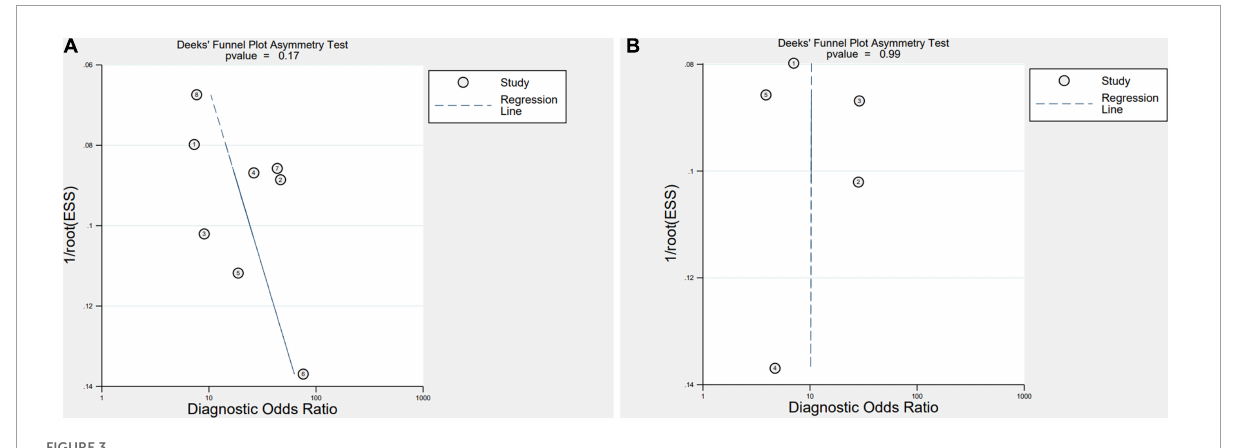
FIGURE3 Deeks’ funnel plot (A) , interleukin 35 (IL-35) (B) , procalcitonin